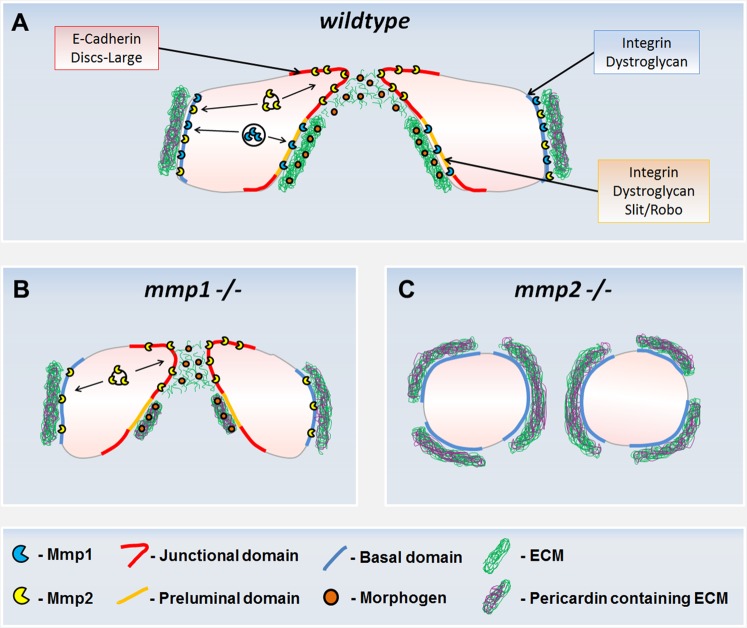
A model describing the mechanism of Mmp1 and Mmp2 function during CCM of CBs.(A) In wildtype stage 16 embryos visualised in cross-section, Mmp2 is targeted to the LE where it cleaves components of the ECM, allowing for stabilisation of a Cadherin domain, and releasing embedded morphogens, possibly Slit, which trigger filopodia and lamellopodia formation. Mmp1 is targeted to the preluminal domain, where it excludes assembly of Cadherin-based adherens junctions and partakes in homeostatic ECM turnover. Pericardin localization is limited to the basal side of the CBs. (B) In mmp1 loss-of-function embryos, Pericardin is present at a reduced luminal ECM, suggesting Mmp1 negatively regulates the size of the Cadherin domain and Pericardin deposition. Mmp2 is likely targeted to the LE where it degrades ECM components and releases embedded morphogens. (C) In mmp2 loss of function embryos, the apical identity of both junctional and preluminal domain is disrupted suggesting Mmp2 is essential for Integrin and Slit mediated CB polarization.